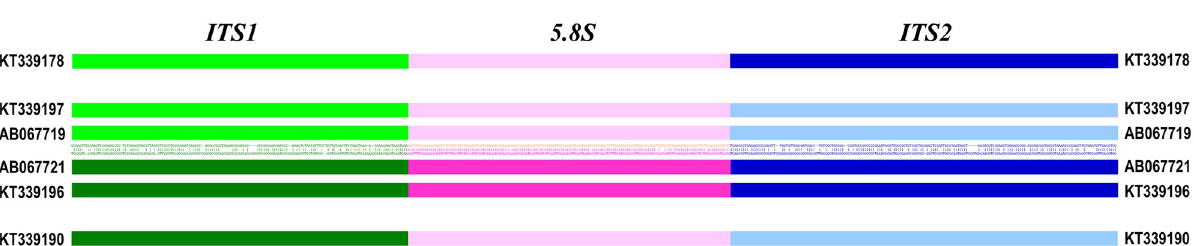
Fig 6. Schematic representation of the ITS segment sequences of the parental fungi ( H . sinensis and the AB067719-type fungus) and O . sinensis offspring Genotypes #13–14. The green bars indicate the ITS1 segment; the pink bars refer to the 5.8S gene; the blue bars represent the ITS2 segment. AB067719 [32] and KT339197 discovered in the current study represent the AB067719-type Group-E fungus and are shown with lighter bars. AB067721 [32] and KT339196 discovered in the current study represent Genotype #1 H . sinensis (Group-A by [66]) and are shown with darker bars. Alignment of the AB067719 and AB067721 sequences is shown between the lighter bars for AB067719 and the darker bars for AB067721. KT339190 and KT339178 represent O . sinensis offspring Genotypes #13 and #14, respectively, showing large DNA segment reciprocal substitutions and genetic material recombination between the genomes of the 2 parental fungi, H . sinensis and the AB067719-type